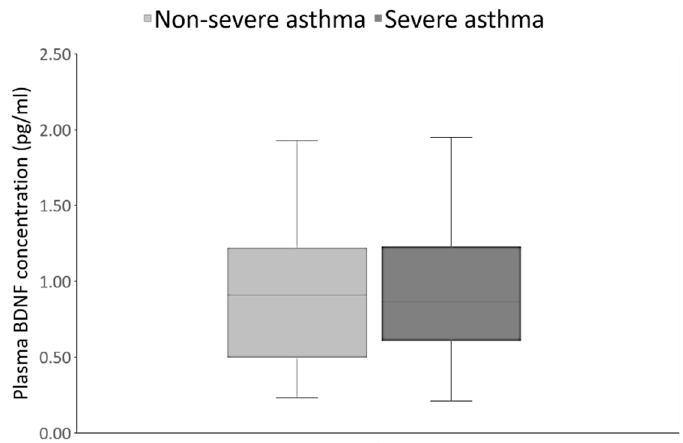
Figure 2. Plasma BDNF concentrations did not differ significantly between the non-severe (0.91 pg/mL, 0.50–1.22) and severe (0.88 pg/mL, 0.61–1.29) asthma patients. p = 0.7094, U = 1728.00, Mann Whitney test.